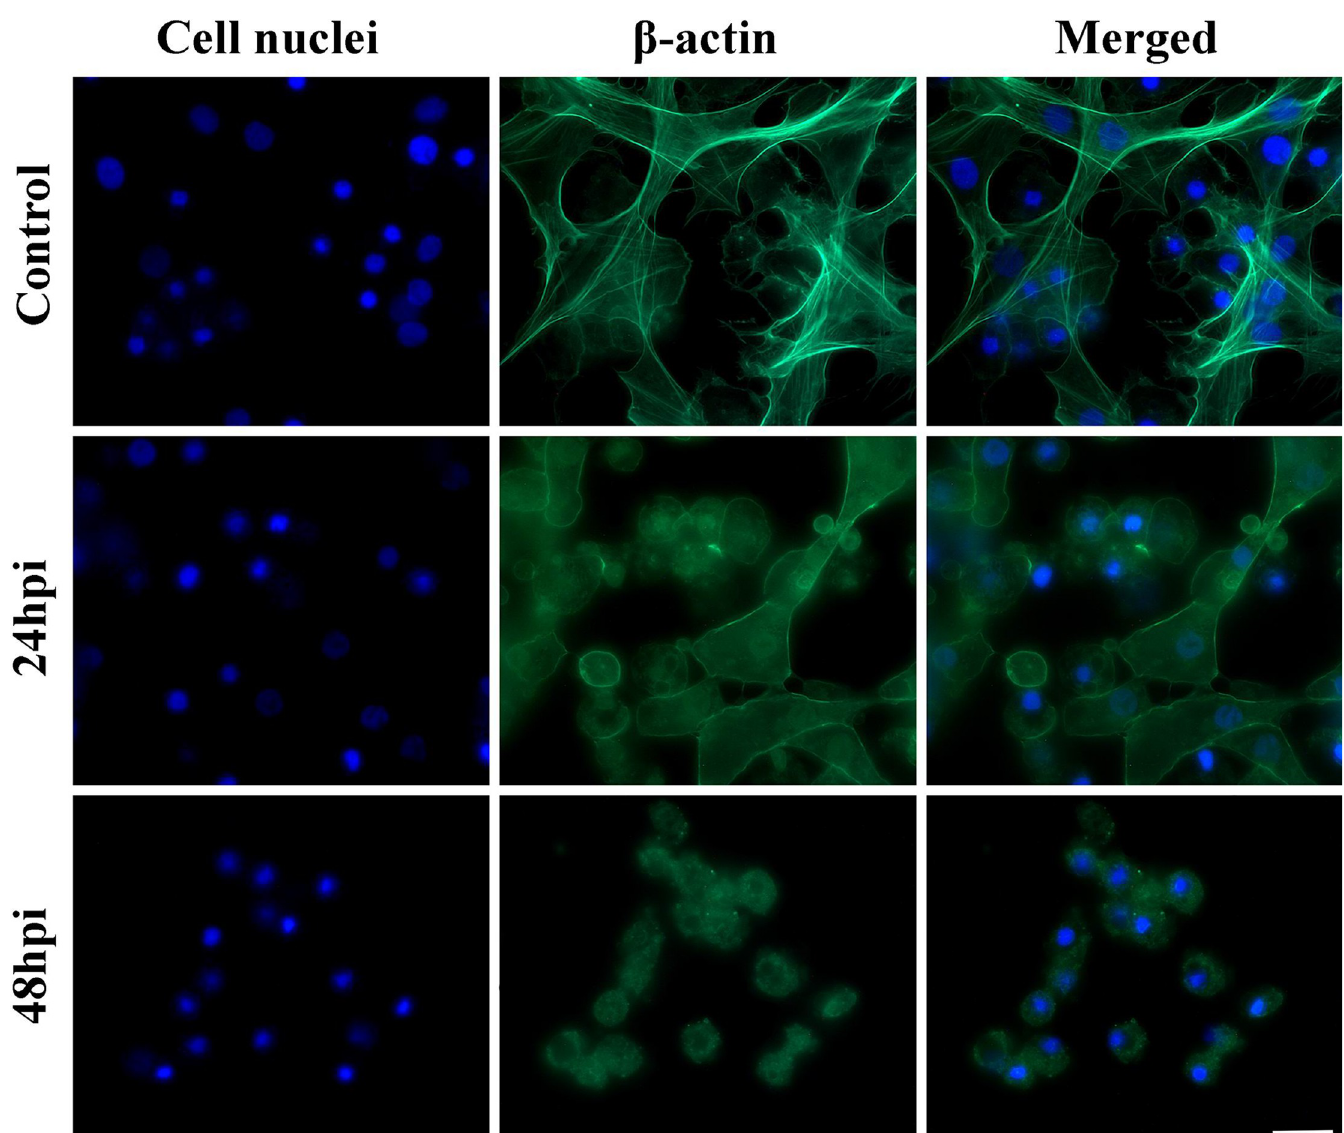
Fig 2. Hemocytes of Galleria mellonella larvae after 24-hour in vitro culture: (A) control, (B) 24 hpi group, (C) 48 hpi group. Larvae were infected with the entomopathogenic fungus Conidiobolus coronatus . Blue color–cell nuclei labelled by DAPI (Ex/Em: 345/455 nm); Green color–actin fibers labelled with ActinGreen 488 kit reagent (Ex/Em: 495/518 nm). Scale bar 20 μ